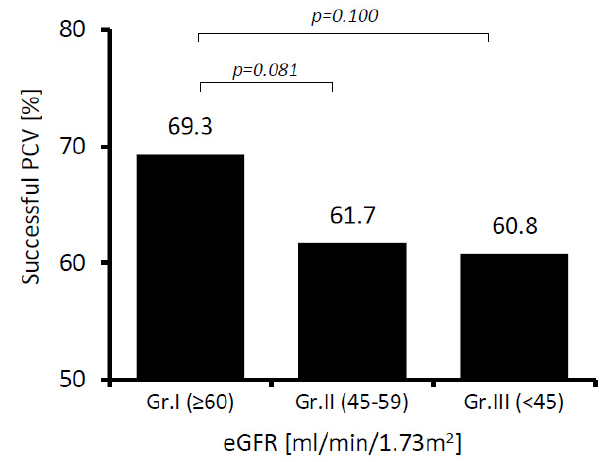
Figure 1. Effectiveness of pharmacological cardioversion (PCV) at different stages of chronic kidney disease. One may see a tendency towards worse PCV effectiveness along with a decrease in eGFR, but the differences between groups are not statistically significant (patients: Group I n = 531; Group II n = 149; Group III n = 97).